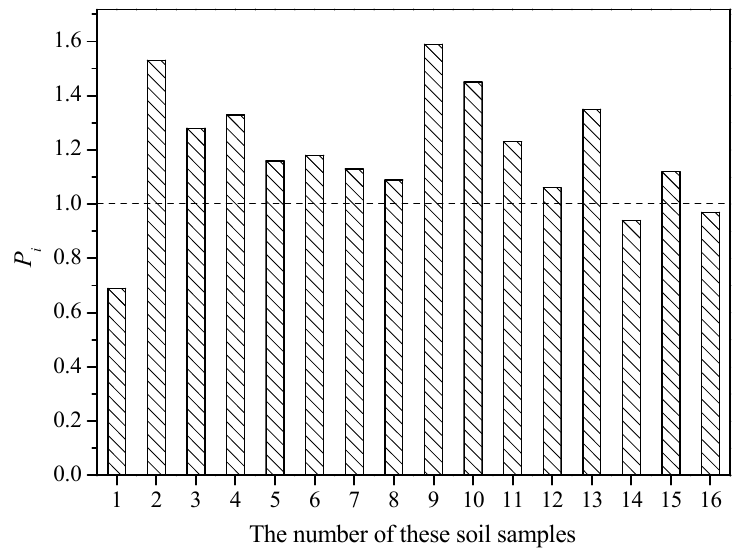
Figure 2. Pollution status of Cd in these paddy soil samples ( n =